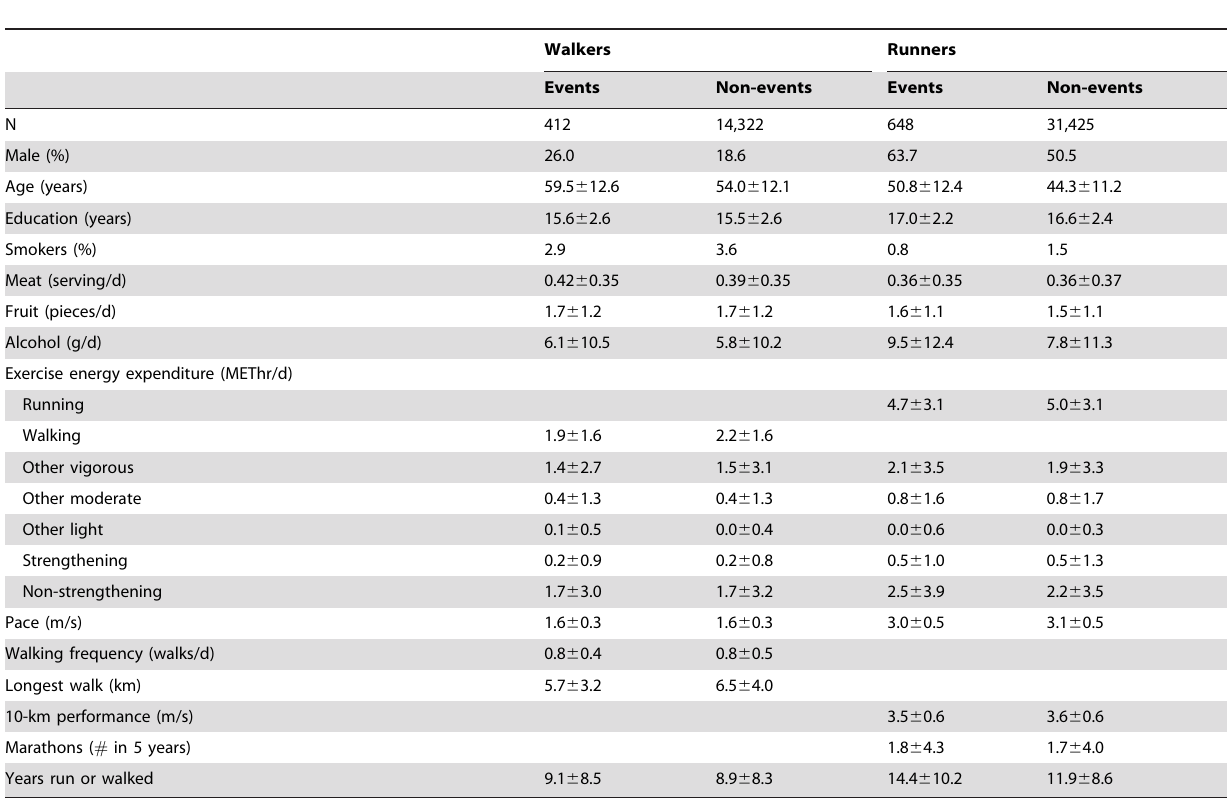
Table 1. Characteristics of walkers and runners by self-reported physician-diagnosed cardiac